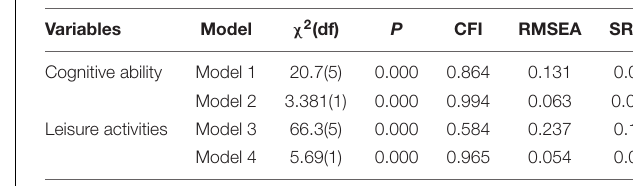
TABLE 3 | Model comparisons for leisure activity and cognitive